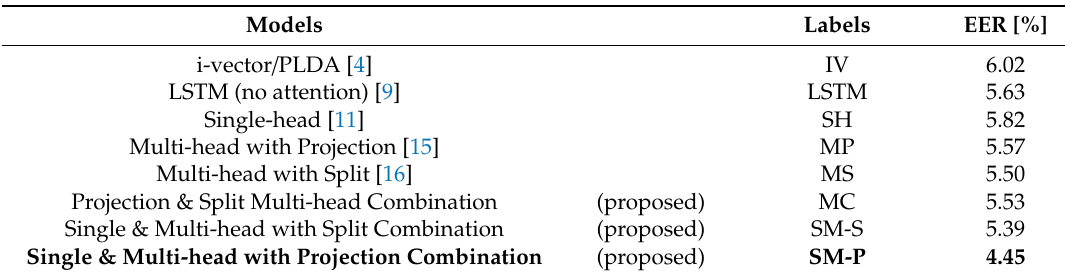
Table 1. Equal Error Rate of speaker verification